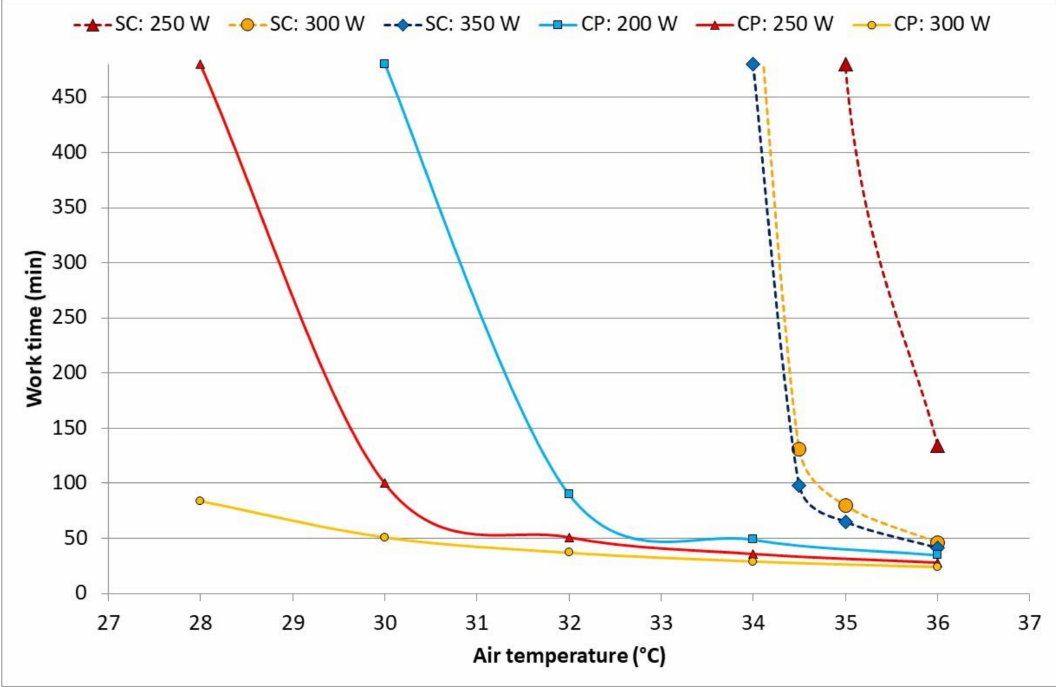
Figure 5. Expected duration limited exposure for sugarcane cutters (SC) and chemical sprayers (CP) at various activity levels based on core temperature (criterion T rec > 38 ◦ C) in a fictive high humidity